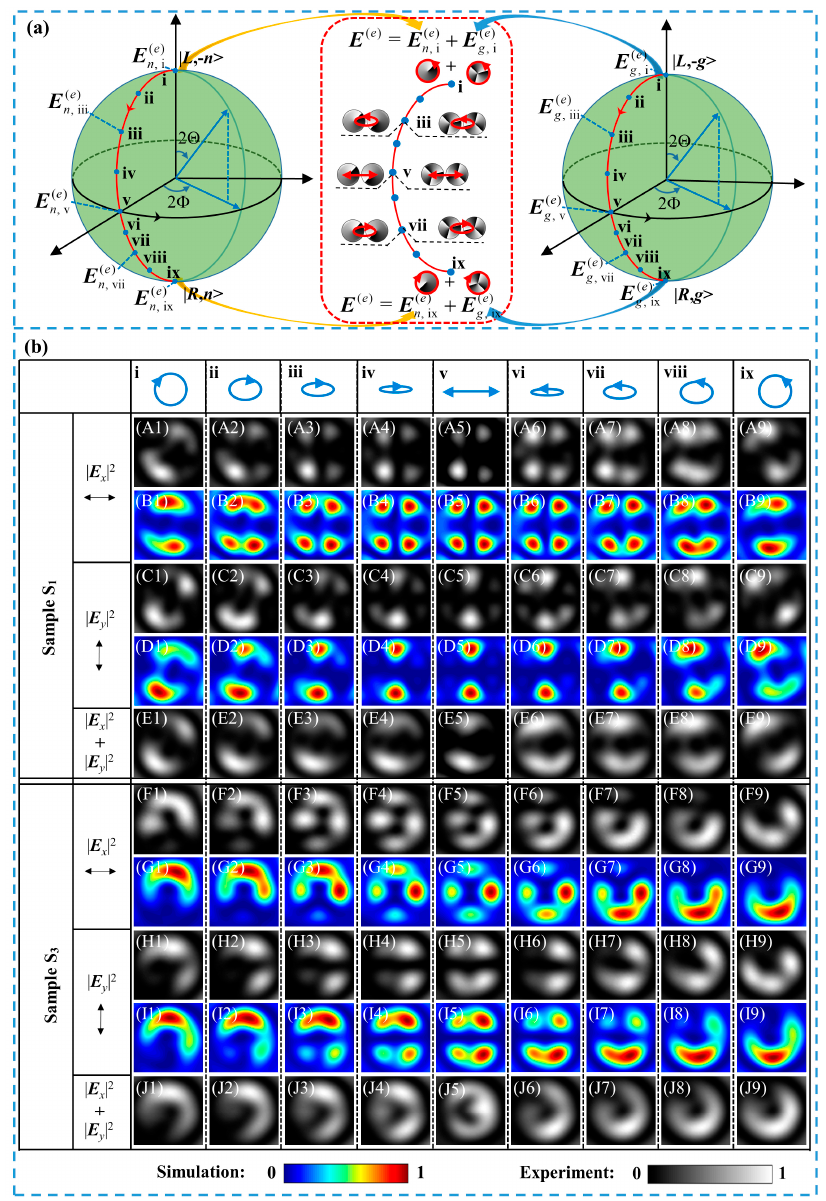
Figure 7. ( a ) The left panel: the HOP spheres of order n ; the right panel: HOP spheres of order g ; middle panel: the illustration of the superposition of the two HOP VBs. ( b ) Experimental and simulation intensities | E x | 2 , | E y | 2 and | E x | 2 + | E y | 2 of the superimposed light fields for the HOP VBs of the order n and g with equal doughnut size produced by samples S 1 and S 3 ,